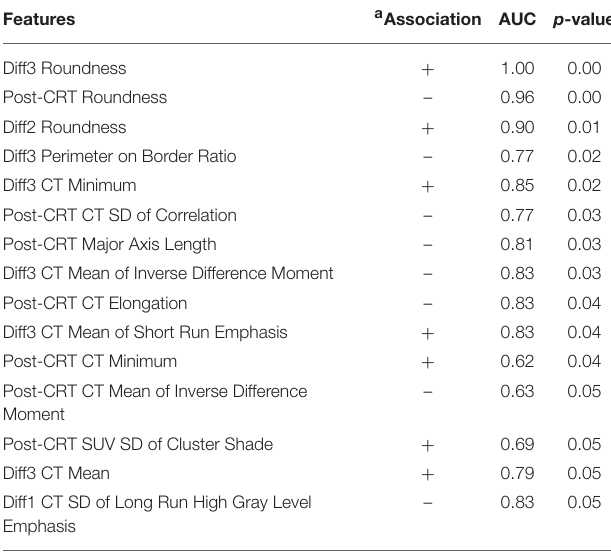
TABLE 2 | Selected anal cancer recurrence predictors from all the image features by univariate logistic regression model.